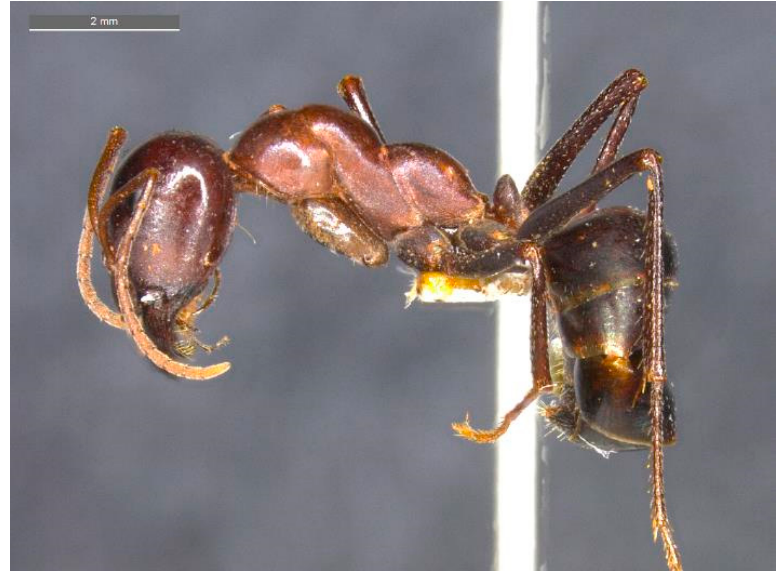
Figure 8. Major worker of Taxon 1E from the sp. 1 complex. Note the saddle-shaped mesosoma that lacks a conspicuous metanotal groove (BOLD ID: DARW622-15).